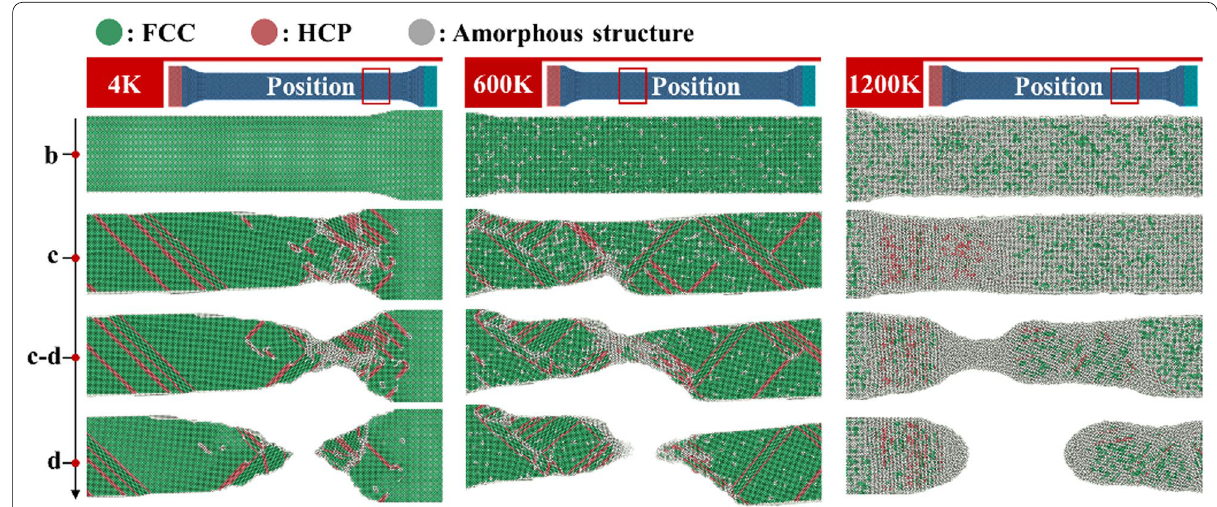
Fig. 4 Crystal structure distribution at 4 K, 600 K and 1200